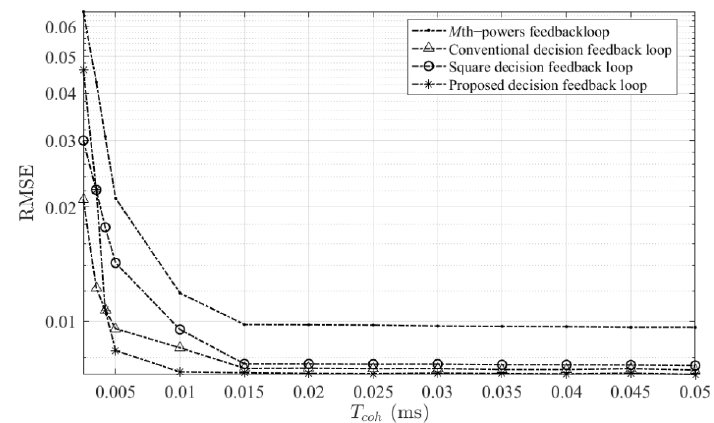
Figure 8. RMSE versus T coh for different feedback loops.